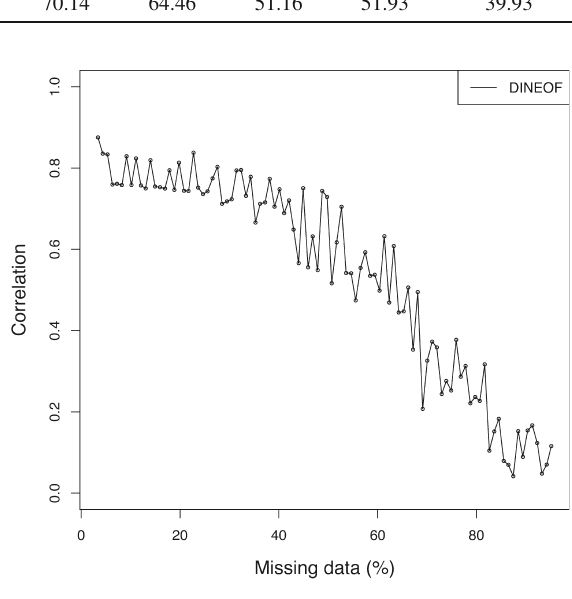
Fig . 6. – Pearson correlation between original and reconstructed